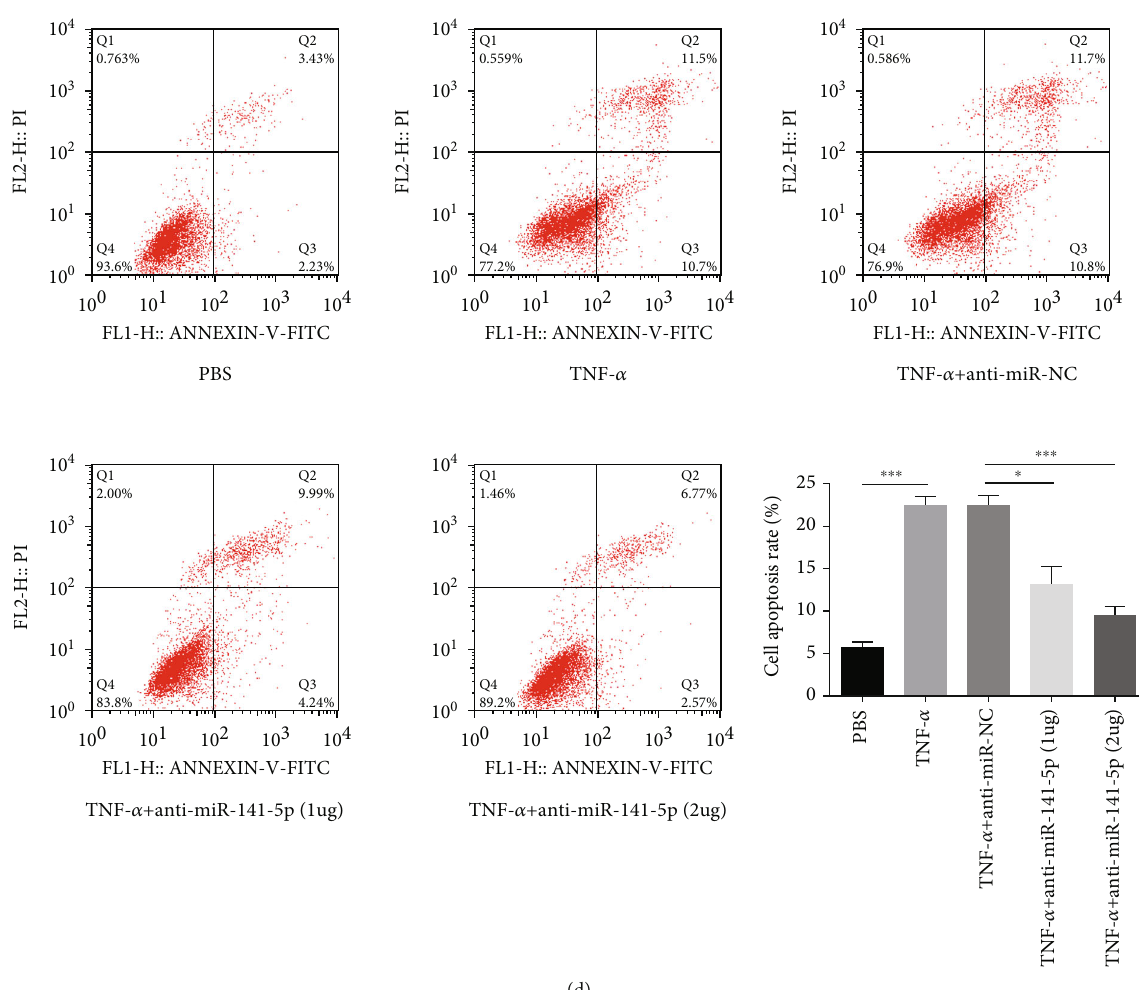
Figure 2: Knockdown of miR-141-5p reverses the e ff ect of TNF- α on primary osteoblasts. (a) anti-miR-141-5p reduced the expression of miR-141-5p more signi fi cantly in primary osteoblasts compared to anti-miR-NC. (b) CCK-8 assays revealed that the knockdown of miR- 141-5p partly reversed the inhibition of cell viability induced by TNF- α when cells were treated with PBS, TNF- α , TNF- α +anti-miR-NC, TNF- α +anti-miR-141-5p (1 μ g), or TNF- α +anti-miR-141-5p (2 μ g), respectively. (c) The increase of Bax and cleaved-Caspase-3 expression induced by TNF- α was inhibited by downregulating miR-141-5p. (d) Annexin V-FITC/PI revealed that the knockdown of miR-141-5p partly reversed cell apoptosis induced by TNF- α . ∗ P < 0 : 05 , ∗∗ P < 0 : 01 , and ∗∗∗ P < 0 : 001